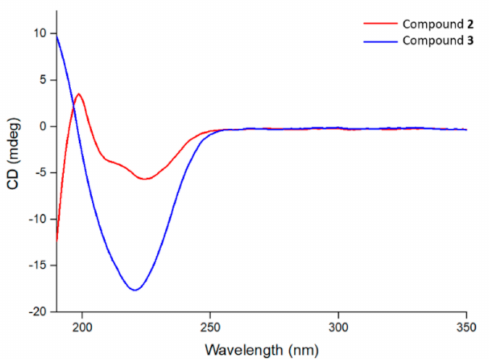
Figure 9. Circular dichroism spectra of compounds 2 and 3 at 0.01 wt.%.